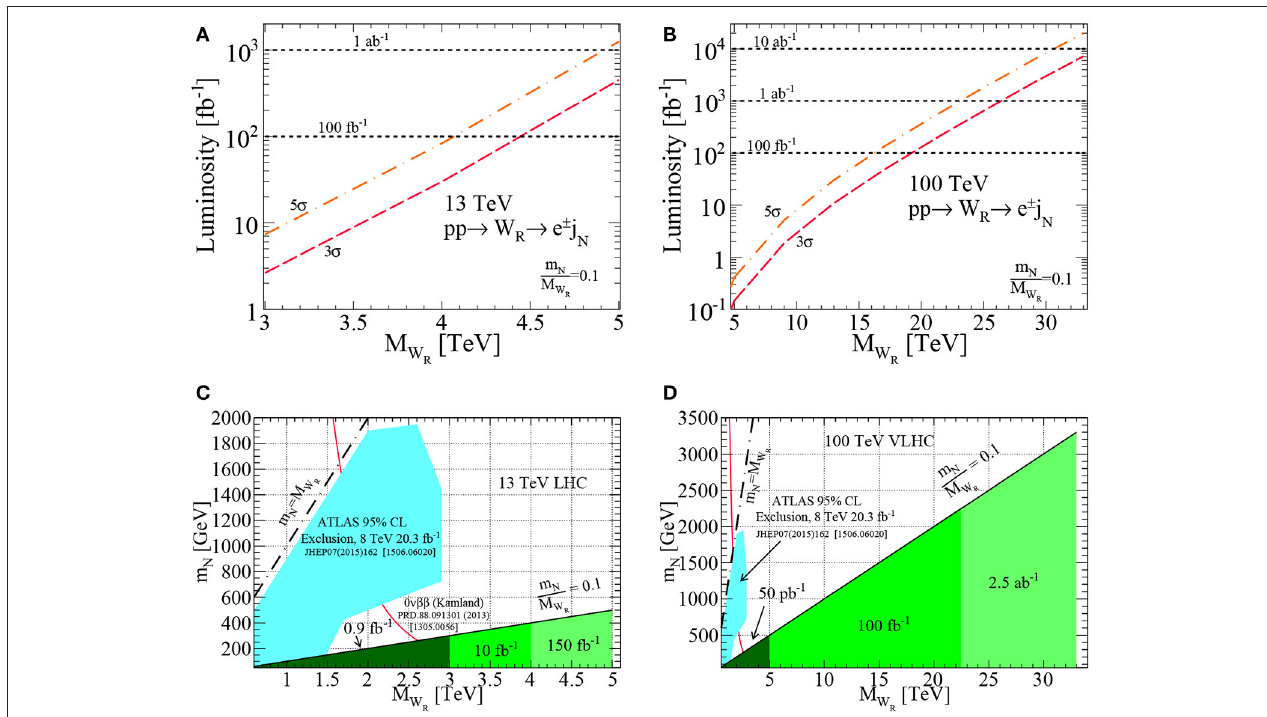
W R e ± j N , at (A,C) √ s 13 and (B,D) 100 TeV. Also → → =